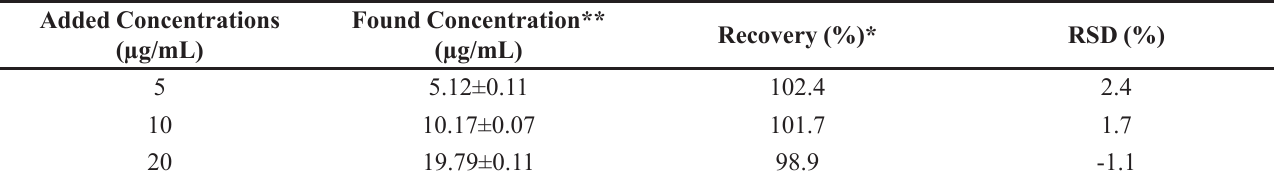
TABLE VII - Results of the accuracy based in the extraction method of the nifedipine from skin samples Added Concentrations